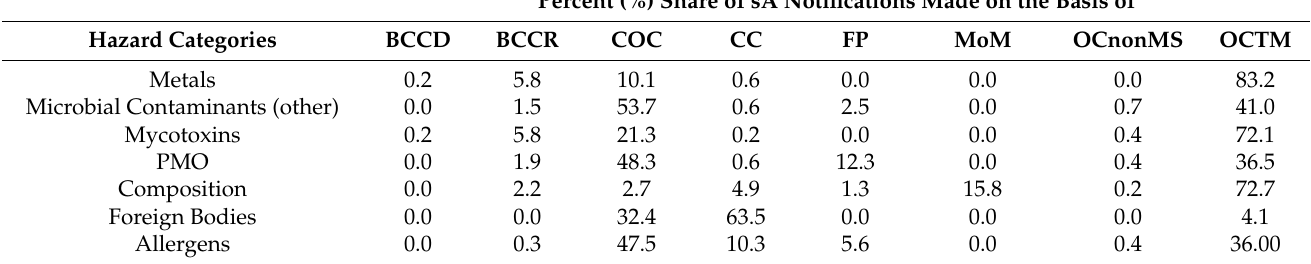
BCCD = border control—consignment detained, BCCR = border control—consignment released, COC = company’s own check, CC = consumer complaint, FP = food poisoning, MoM = monitoring of media, OCnonMS = official control in non-member state, OCTM = official control on the